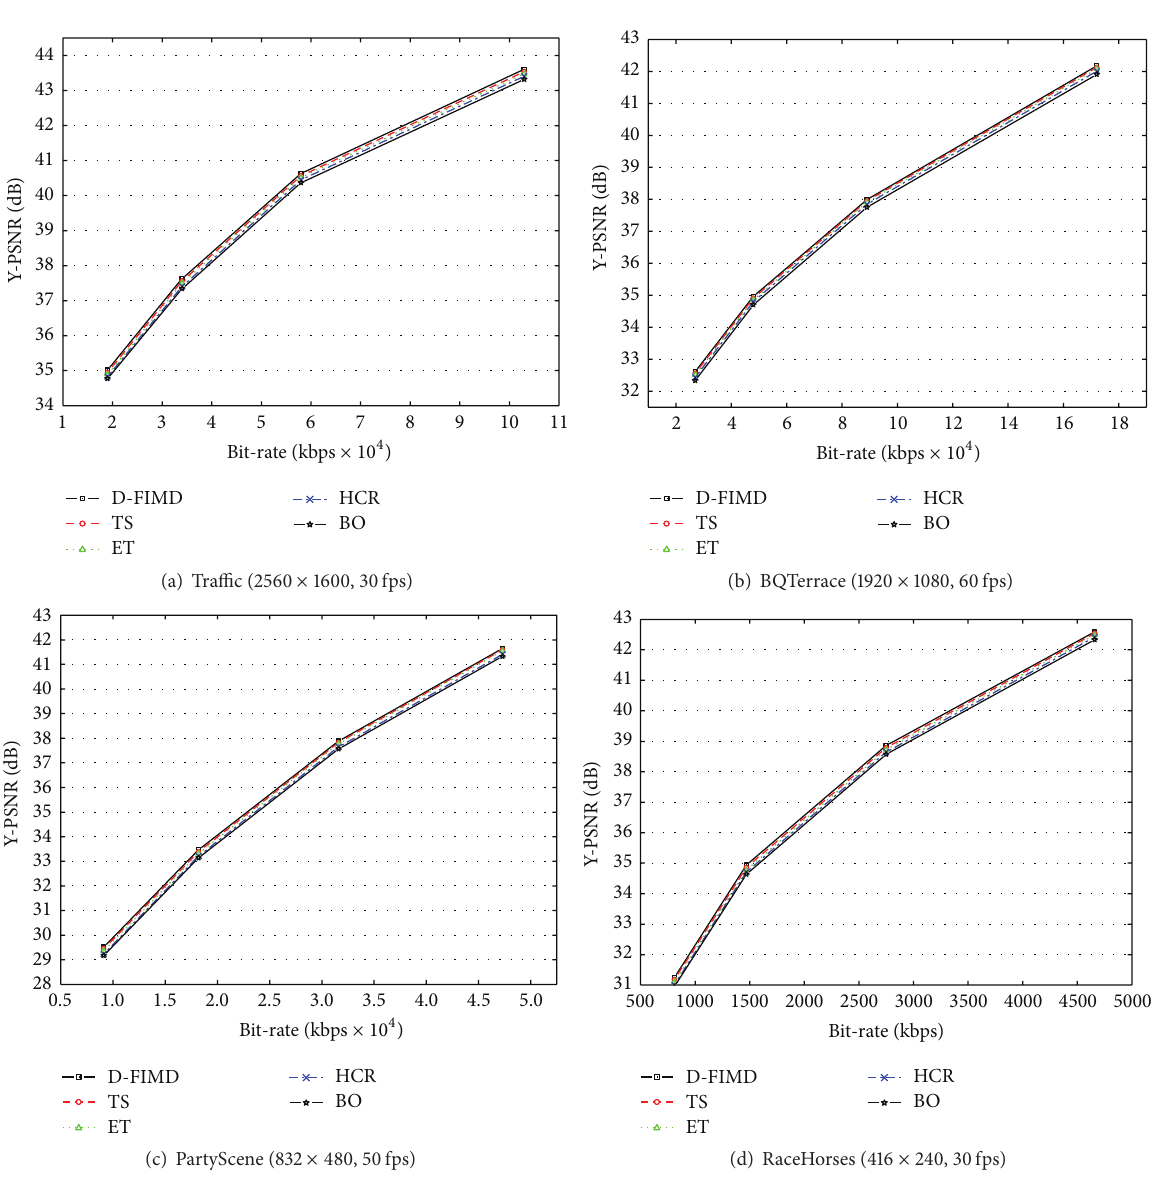
Figure 6: R-D curves of four test sequences for different